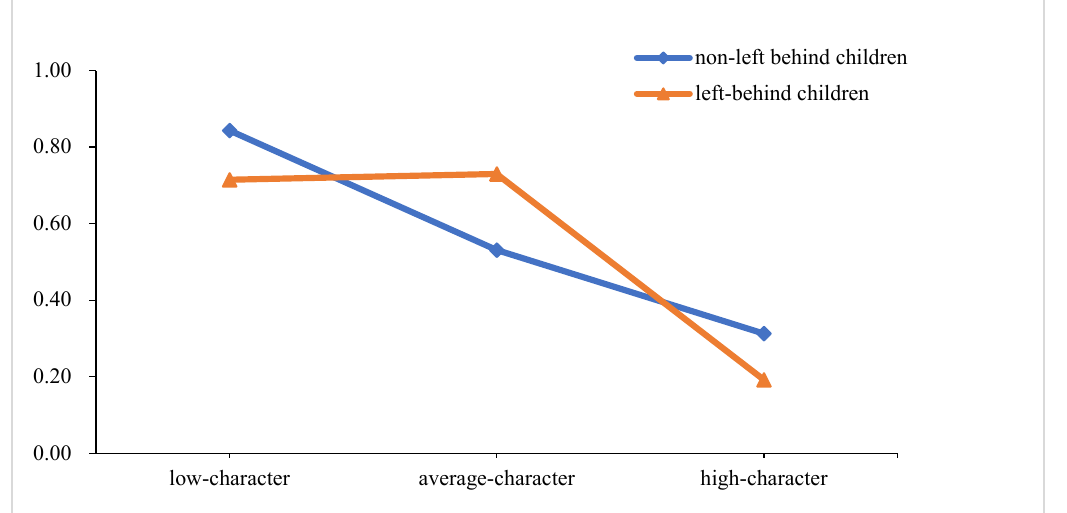
Figure 2. Interaction effect of left-behind status with latent character class on bullied behavior.